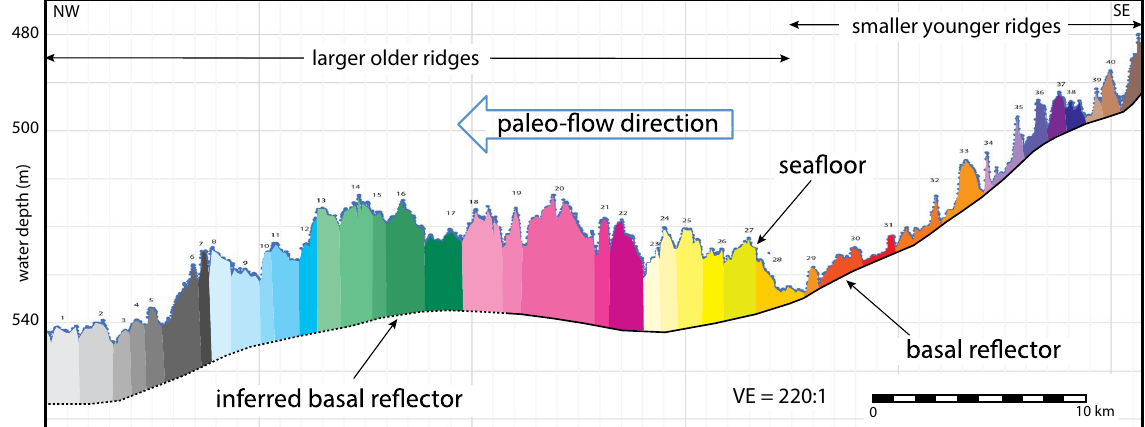
Figure 4. Representative NW–SE cross section of the ridge field. The basal reflection below ridges 1–28 is inferred whereas that below ridges 29–50 is from the sonar data. The colors show our interpretation of individual ridges. The location of cross section is shown on Fig.